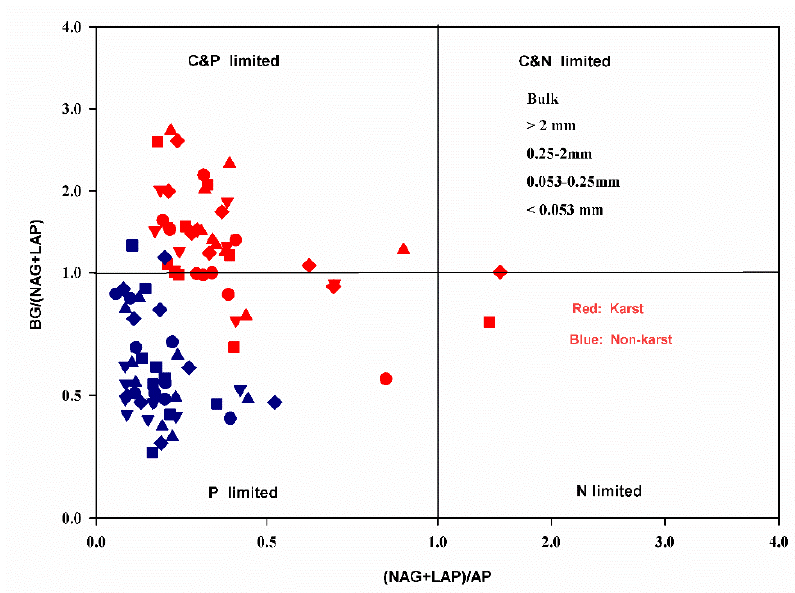
Figure 2. Scatter plots of the soil exoenzymatic stoichiometry for the studied sites. Red and Blue dots represent karst and non-karst, respectively. Different symbols represent different aggregate sizes.